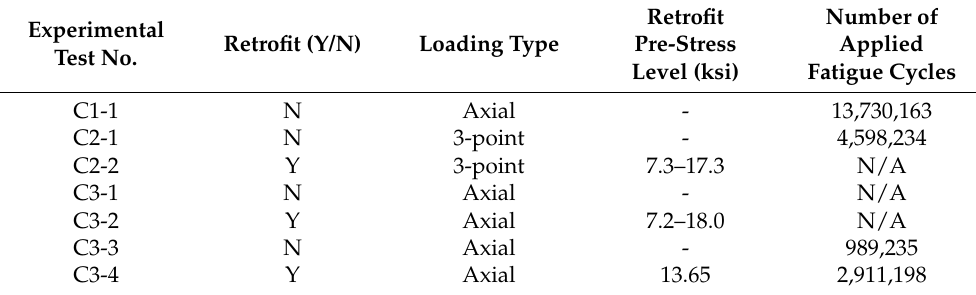
Table 8. Experimental test matrix and resulting fatigue cycles